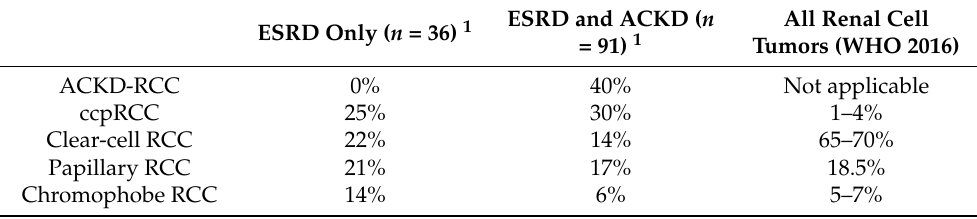
Table 1. Major RCC types and frequencies in ESRD, ACKD, and among all renal cell